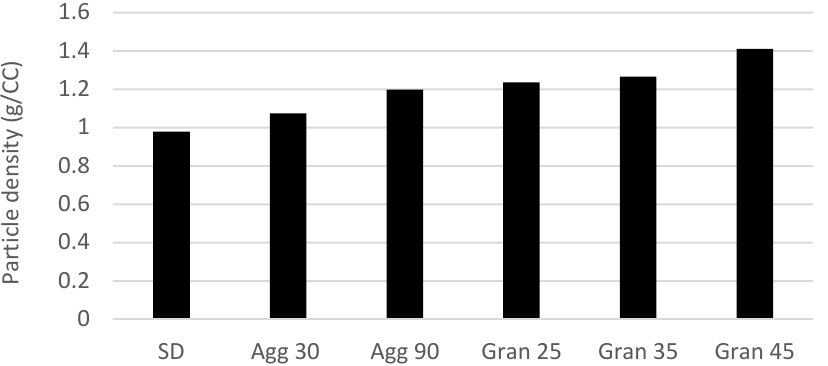
Figure 4. Influence of process (SD—spray dry; Agg xx—agglomeration min; Gran xx—granulation min) on powder density (values denote an average value of sample duplicates).